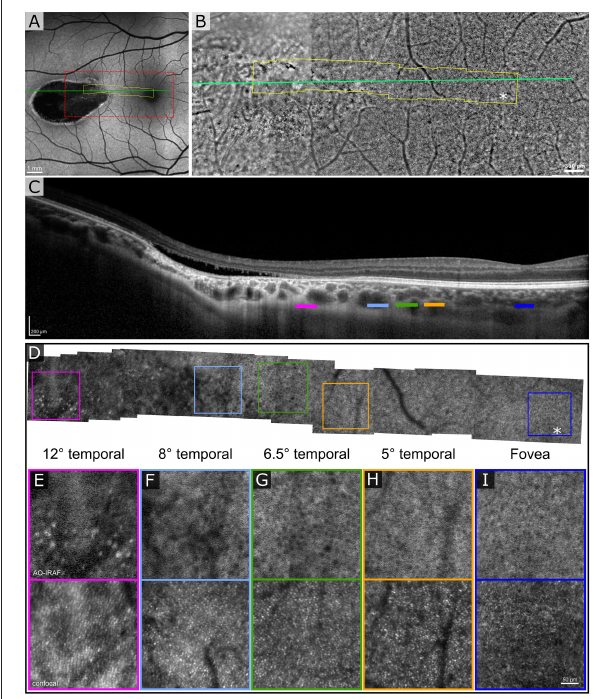
FIGURE 2 | Adaptive optics (AO) assisted imaging of patient 1. (A) Blue autofluorescence image showing the location of the lesion with red dashed box indicating the area imaged with the flood-illumination adaptive optics (FIAO) retinal camera and green line showing the location of the OCT scan. (B) FIAO montage showing typical photoreceptor mosaic in the region of the fovea. Near the lesion, the cone signature becomes irregular and cannot be distinguished anymore. The yellow area indicates the area that was imaged with the AOSLO. (C) OCT B-scan showing the cavity, indicating Type II torpedo maculopathy. Different color bars indicate roughly the location where AO-IRAF images where obtained. (D) AO-IRAF montage showing typical RPE cell mosaic. The cell size increases when moving to higher eccentricities and when reaching the lesion border, the mosaic eventually disappears. (E–I) Zoomed images of the regions of interest from the montage. Hypo-fluorescent spots are seen in (E) suggesting fluorophore accumulation in the lesion itself. Bottom row showing corresponding confocal image from the areas (E–I)